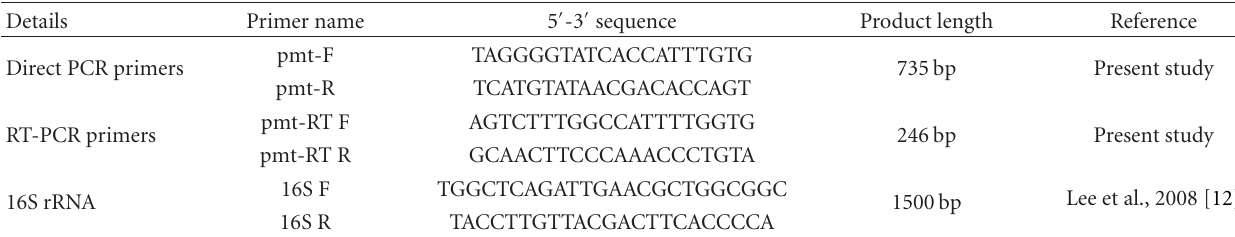
Table 2: Oligonucleotides used in the